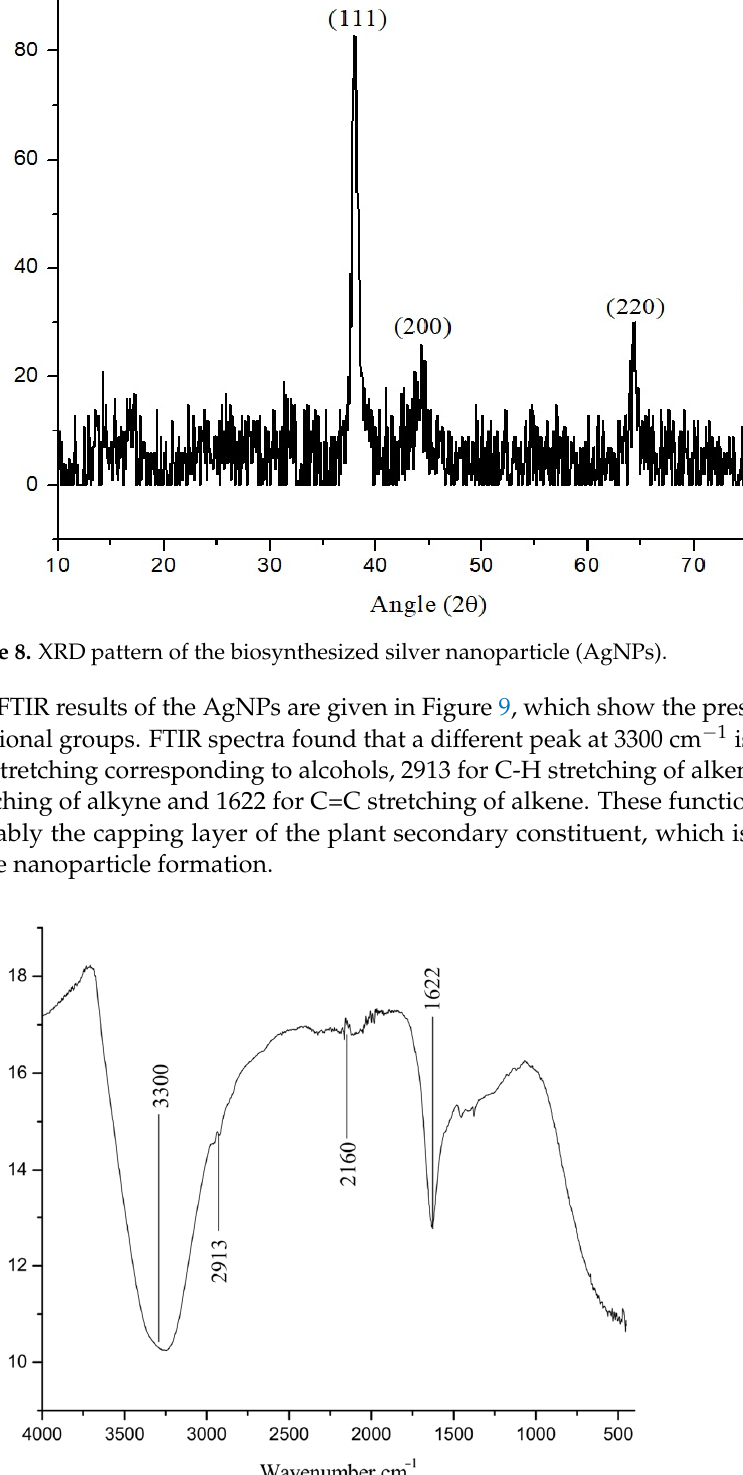
The AgNPs (1000 μ g/mL) and AgNPs ‐ PE (1000 μ g/mL) strongly inhibited the growth of X. axonopodis , while PE showed an optimum inhibition in comparison to the control (water) treatment. Our finding revealed that the highest inhibition was 98% by AgNPs (1000 μ g/mL) and 93% by AgNPs ‐ PE (1000 μ g/mL), which were significantly comparable. However, the plant extract (1000 μ g/mL) alone inhibited the growth by 53.6%. No inhibi ‐ tion in the cell growth of X. axanopodis was observed by the control treatment (Figure 10). Figure 10. Inhibition of X. axonopodis in response to different concentrations (1000 μ g/mL, 500 μ g/mL, 250 μ g/mL, 125 μ g/mL, 62.5 μ g/mL, 31.25 μ g/mL, 15.62 μ g/mL) of washed silver nanoparti ‐ cles (AgNPs), plant extract ‐ coated silver nanoparticles (AgNPs ‐ PE) and plant extract (PE). Bars with zero concentration represent control. Bars with the same letters are not significantly different. Dif ‐ ferent concentrations of each treatment were analyzed by Tukey’s HSD separately.